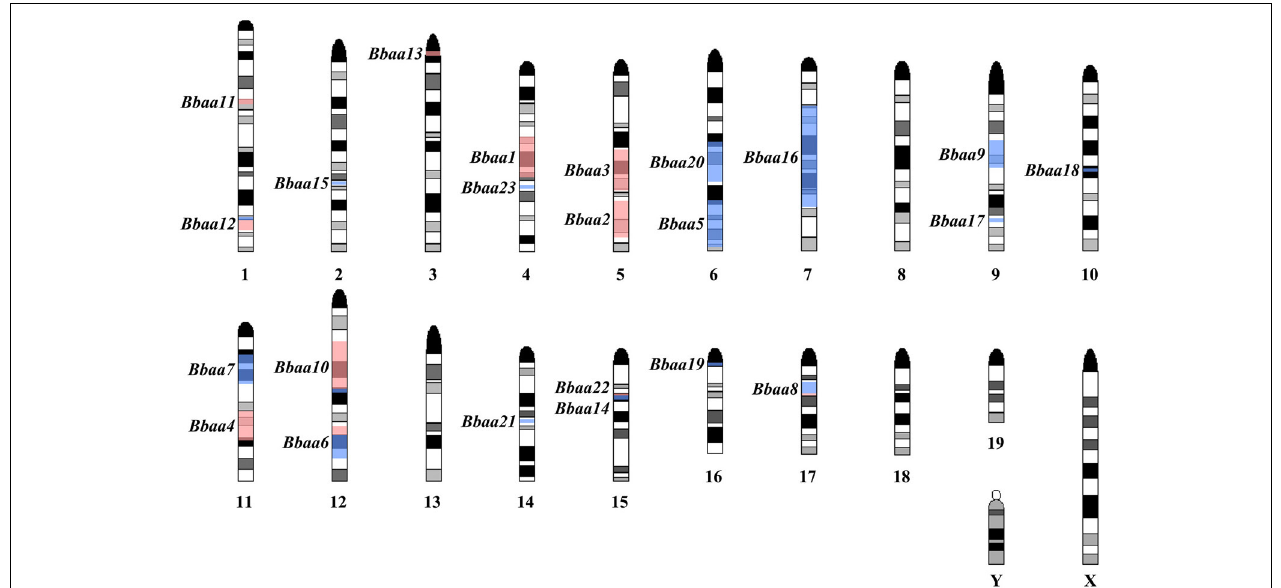
FIGURE 2 | Location of predicted Quantitative Trait Loci, summarized from Weis et al. (1999) and Roper et al. (2001). Black and gray bands on each chromosome denote an idealized representation of the Giemsa banding pattern found in a normal mouse karyotype. Red shaded regions denote QTL